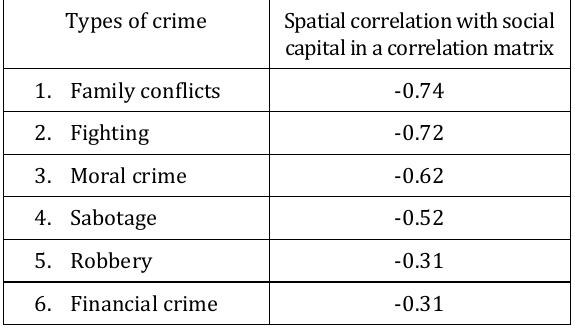
Table 1. Spatial correlation of social capital and crime Types of